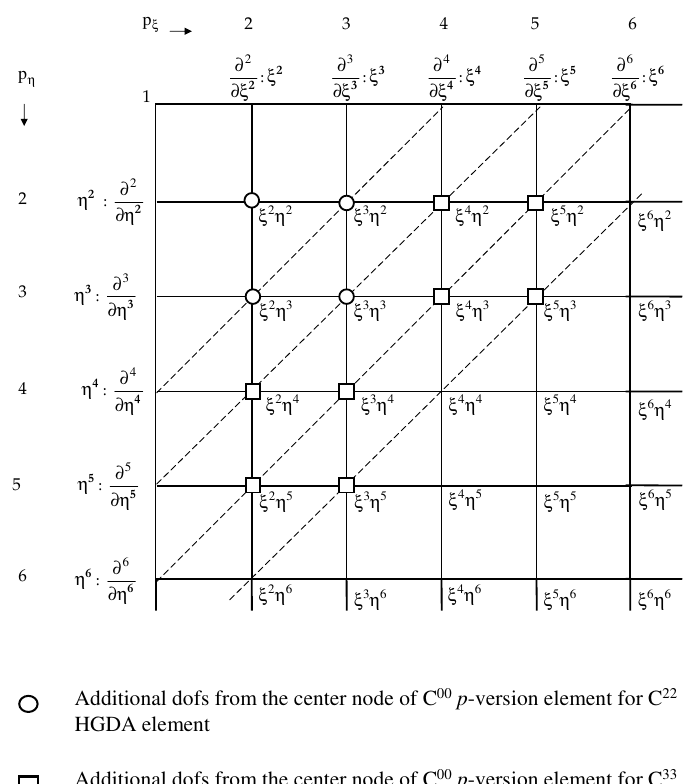
Figure 8. Dofs at the center node of a C 00 p -version hierarchical